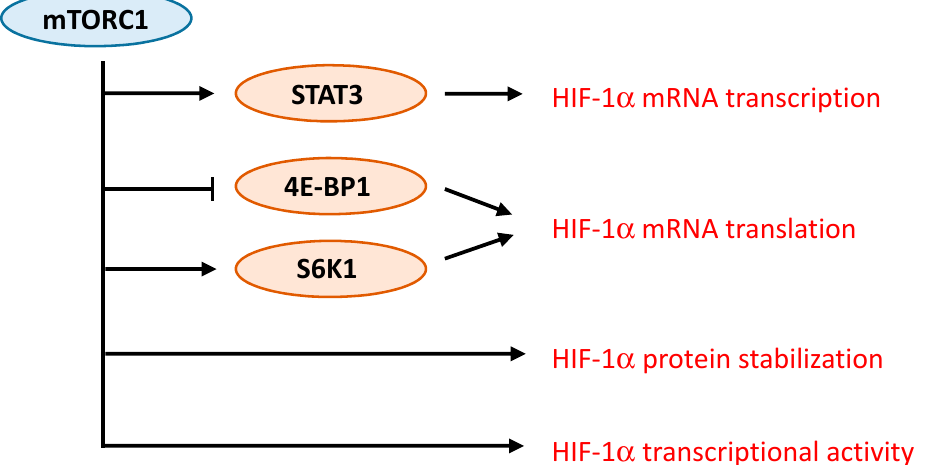
Figure 3. mTORC1 regulates HIF-1 α signaling via different mechanisms. mTORC1 controls HIF-1 α mRNA transcription and translation, HIF-1 α protein stability and HIF-1 α transcriptional activity.